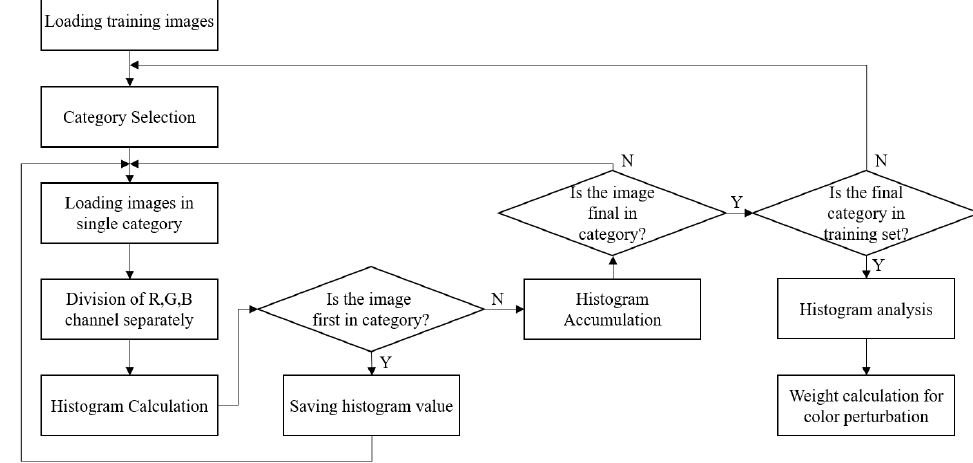
Figure 6. Partial training images and histogram of images in its